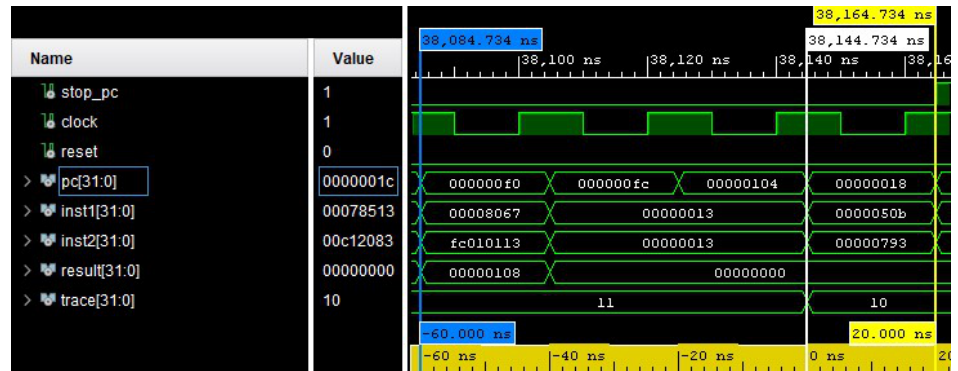
Figure 11. Execution results of an unconditional jump (0xf0). In the first cycle, the jump is executed. At the next two cycles, NOP instructions are executed due to the unconditional jump. At the last cycle, the jump’s target instruction (0x14) is executed as can be seen on the variation from 11 to 10 of the trace value.